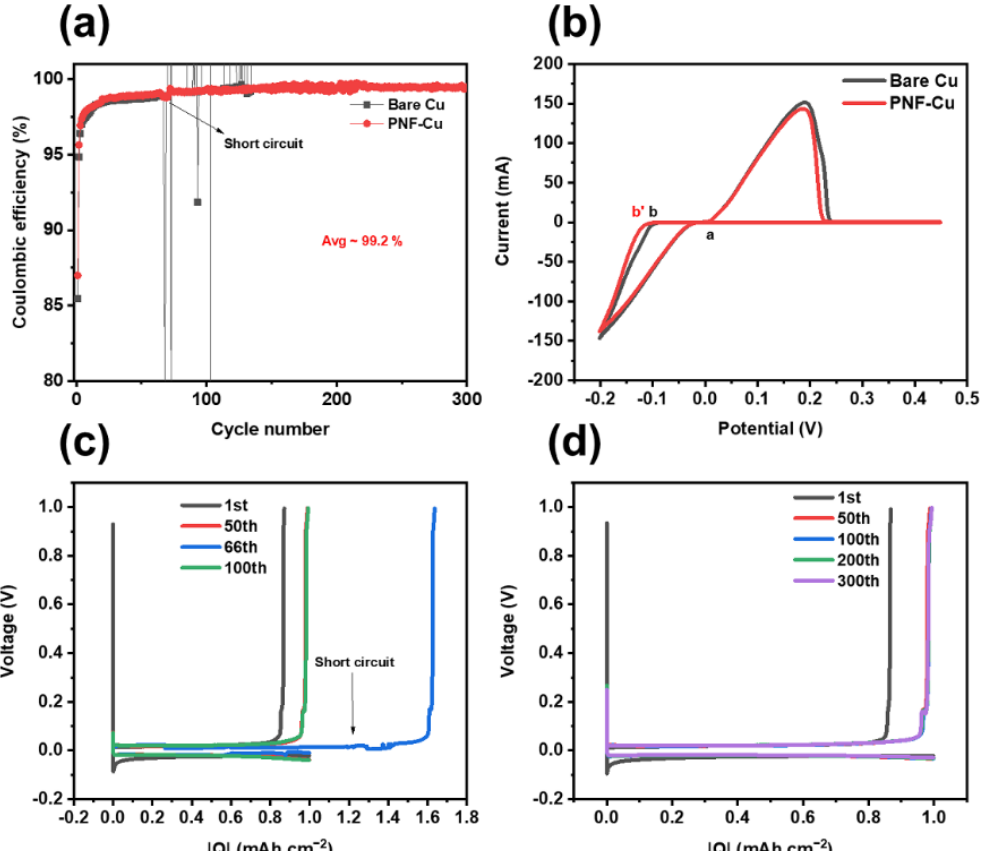
Figure 4. ( a ) Coulombic efficiency, ( b ) cyclic voltammetry, and voltage profile of ( c ) Zn‖Cu half cell and ( d ) Zn‖PNF -Cu half cell.